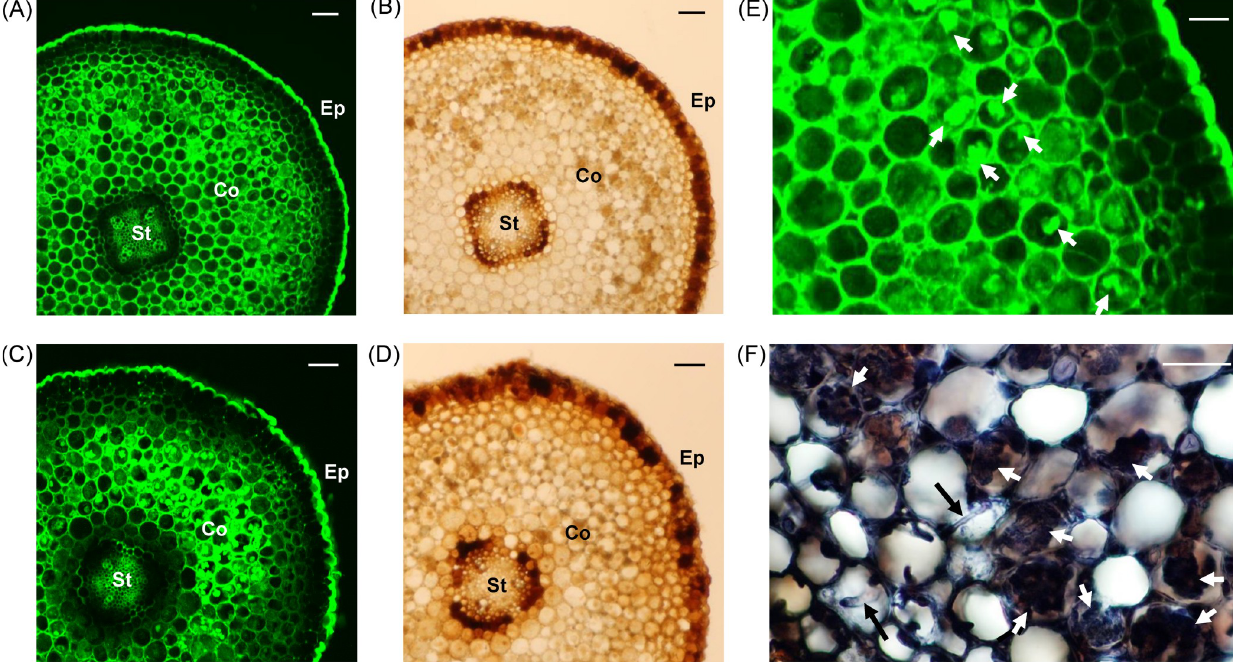
Fig 2. Zn localization in the roots of A . japonica . (A) Zn localization in roots collected in July 2017 (summer). (B) Optical microscopically observed root sections collected in July 2017 (summer). (C) Zn localization in roots collected in January 2018 (winter). (D) Optical microscopically observed root sections collected in January 2018 (winter). (E) The extended images of the root cortex and epidermis of Fig 2A. (F) Trypan-blue stained fungal structures in the roots collected in July 2017. The green color indicates fluorescence derived from the Zinpyr-1 complex with Zn. St, stele; Co, cortex; Ep, epidermis. White arrows indicate the fungal structures, and black arrows indicate fungal hyphae. The Scale bars in Fig 2A–2D represent 100 μ m, and Fig 2E and 2F represent 50 μ m.